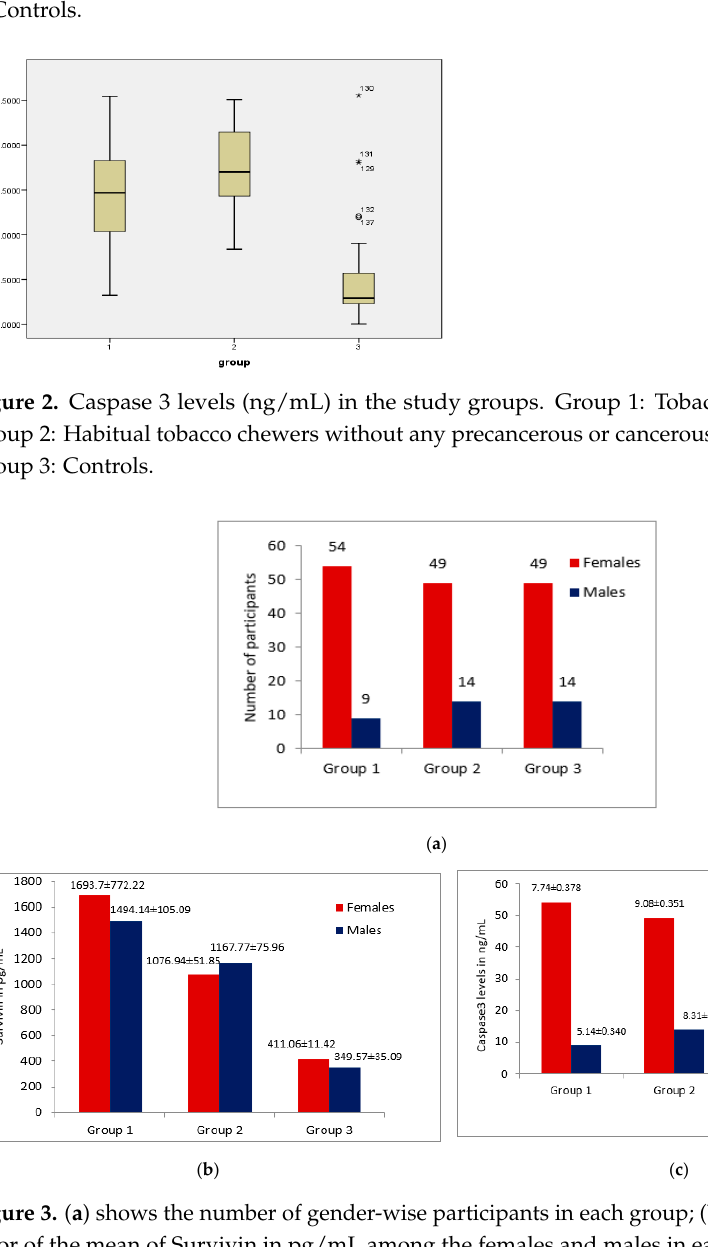
Figure 1. Survivin levels (pg/mL) in the study groups. Group 1: Tobacco chewers with OSCC, Group 2: Habitual tobacco chewers without any precancerous or cancerous lesion in the oral cavity, Group 3: Controls.